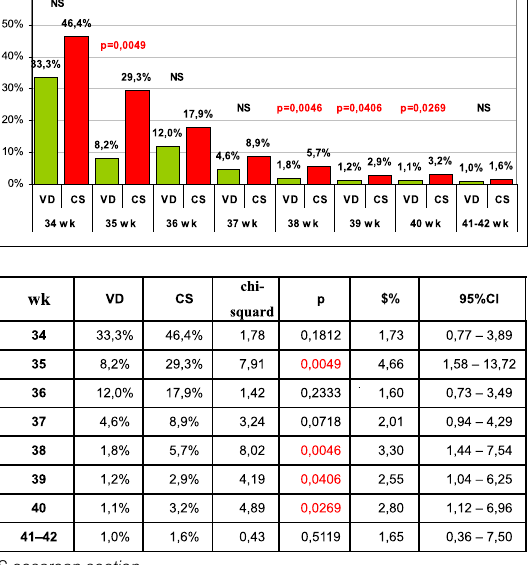
Figure 4. Statistical diferences between respiratory distress syndrom in late preterm and term infants deliveried by cesarean section and vaginaly delivery and conditional odds ratio (OR) and 95% confidence interval (CI)